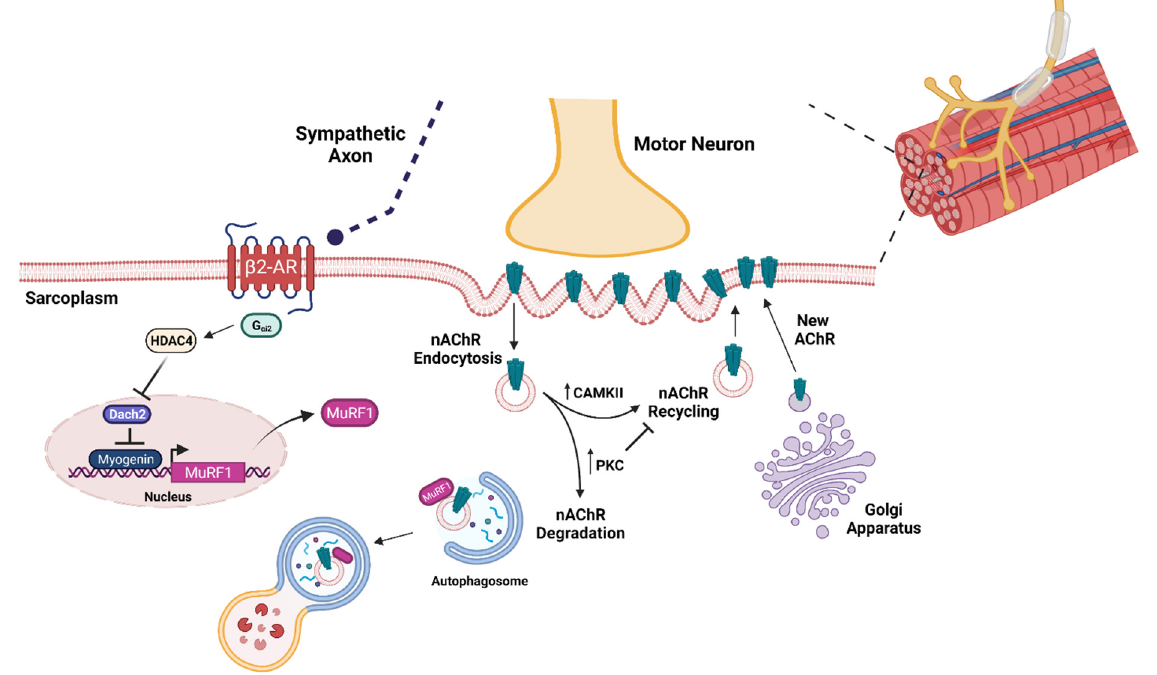
Figure 3. Involvement of the lysosome–autophagosome and ubiquitin–proteasome systems in acetylcholine receptor turnover at the neuromuscular junction. In the Golgi apparatus, newly formed nicotinic acetylcholine rectors (nAChR) are shuttled to the sarcolemma by rapsyn, where under the motor neuron terminal, they cluster together. Turnover of nAChRs begins with endocytosis, and then depending on the signaling pathway activated, the receptors are recycled or degraded. Activation of PKA or CaMKII leads to recycling, while activation of PKC or inhibition of PKA or CAMKII leads to degradation via autophagy. Under atrophy conditions, such as denervation, nAChR degradation is increased and MuRF1 has been shown to colocalize with endocytosed nAChRs and components of the autophagosome. Furthermore, decreases in sympathetic input at the NMJ has been shown to increase nAChR turnover through a HDAC4- myogenin-MuRF1 axis. Created with Biorender.com. Reprinted/adapted with permission from Rudolf and Straka [89] (2022, Wiley and Sons, Hoboken, NJ, USA), and Rodrigues et al. [99] (2022, Elsevier, Amsterdam, The Netherlands).